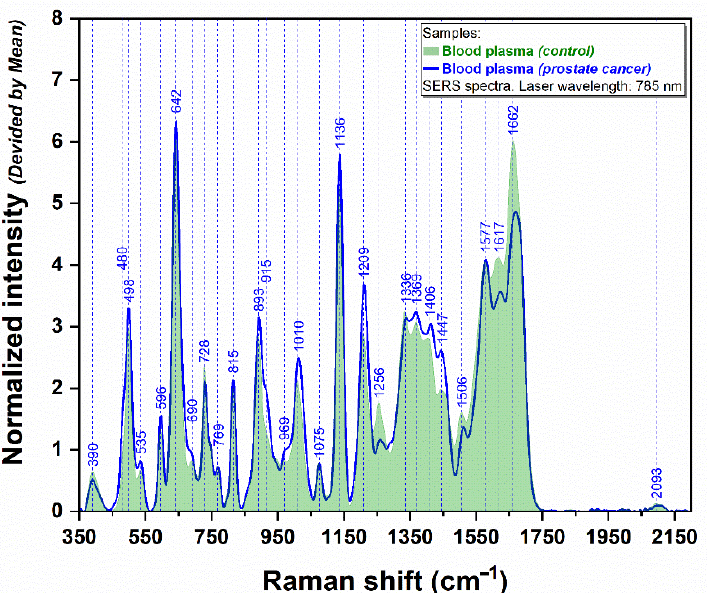
Figure 1. The average SERS plasmatic spectra obtained from PCa patients ( n = 27, blue spectrum) and healthy donors ( n = 14, green spectrum), using a 785 nm laser.